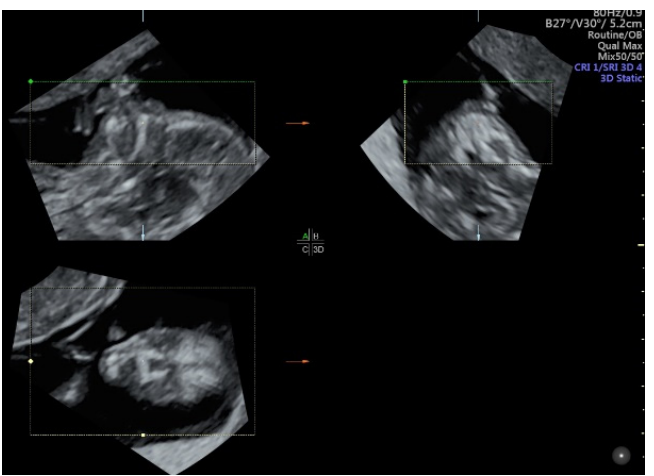
Figure 10. Three-dimensional ultrasound assessment of the fetal face at 13 weeks’ gestation showing multiplanar views of lip and palate (reference dot).